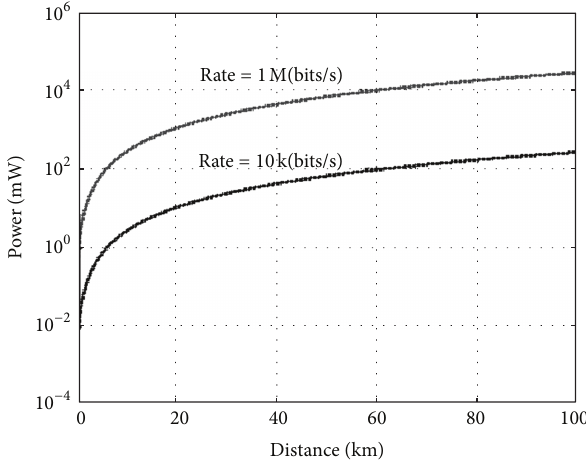
Figure 1: Simulated graph of transmitted power relative to